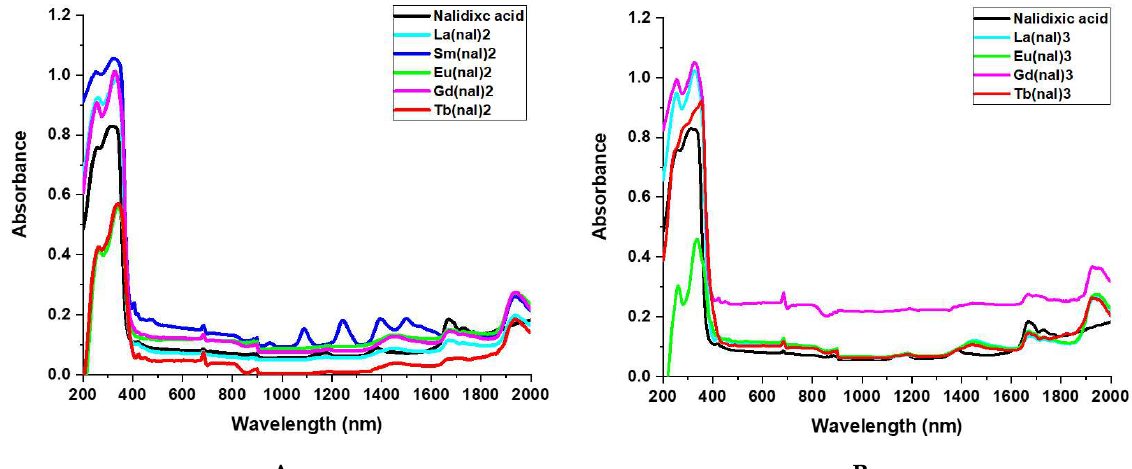
Figure 2. UV–Visible spectra of ( A ) nalidixic acid and M(nal) 2 , where M = La 3+ , Sm 3+ , Eu 3+ , Gd 3+ , Tb 3+ ); ( B ) nalidixic acid and M(nal) 3 , where (M = La 3+ , Eu 3+ , Gd 3+ , Tb 3+ ).